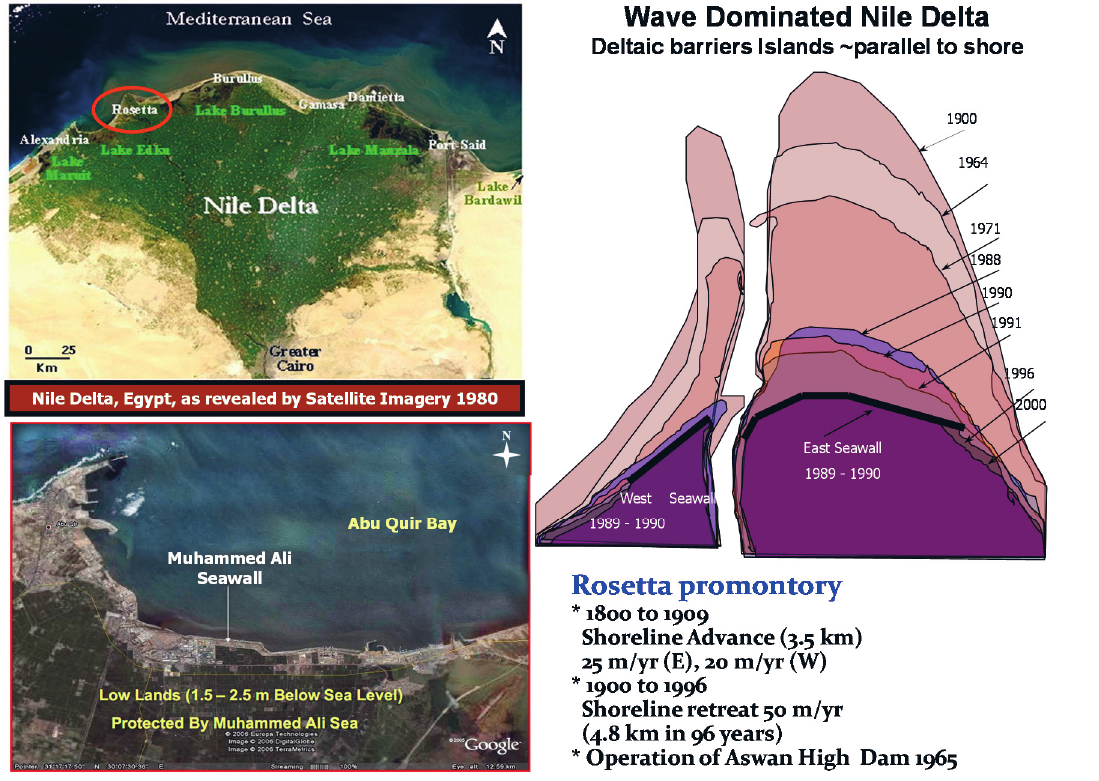
Figure 3. Coastal retreat of Rosetta Headland (1900 to 2010) and M. Ali Seawall [11] from open source maps.